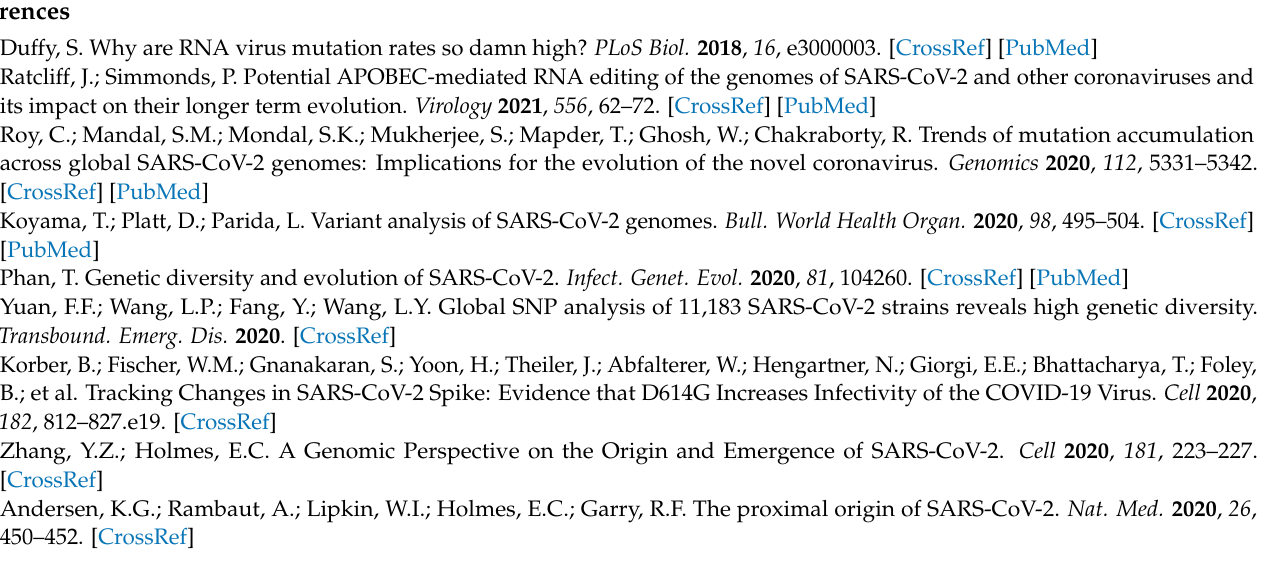
Table S8: Frequency of nucleotides in motifs flanking the C>U substitutions. Table S9: Nucleotide composition in consensus genomes sequences from different clades. Table S10: Relationship between biochemical properties of amino acids and nucleotide compositions of corresponding codons. Figure S1: Characters of amino acids induced by SNVs along the SARS-CoV-2 genome—comparison of different hydrophobicity scales. Figure S2: Changes in amino acid hydrophobicity induced by different types of single nucleotide substitutions in different SARS-CoV-2 clades. Figure S3: Relative frequency of synonymous/non-synonymous SNVs in individual SARS-CoV-2 regions. The number above the columns indicates SNV counts. Figure S4: Computer prediction of antigenicity profiles of SARS-CoV-2 Spike proteins. Figure S5: Base frequency in motifs flanking the C>U substitutions (the source data are in Table S8). Figure S6: Alignment of selected genomes from the GR and G